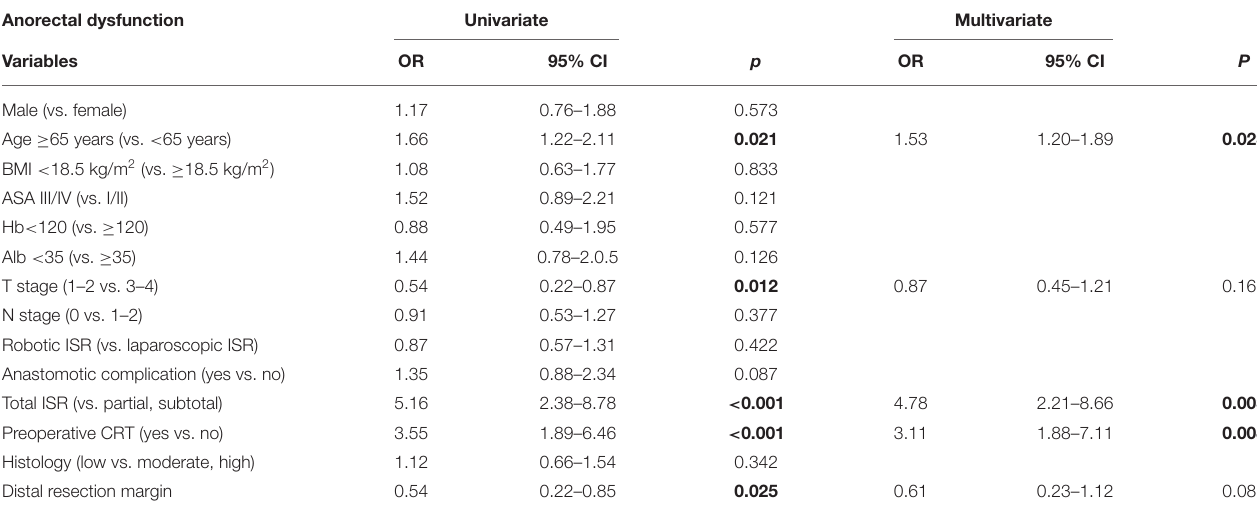
TABLE 6 | Univariate and multivariate analyses for the risk of anorectal